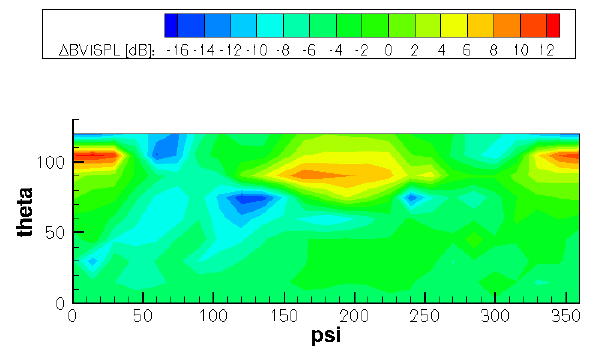
Figure 21: Technique A – B differential BVISPL at point 1 in maneu- ver ID8023.